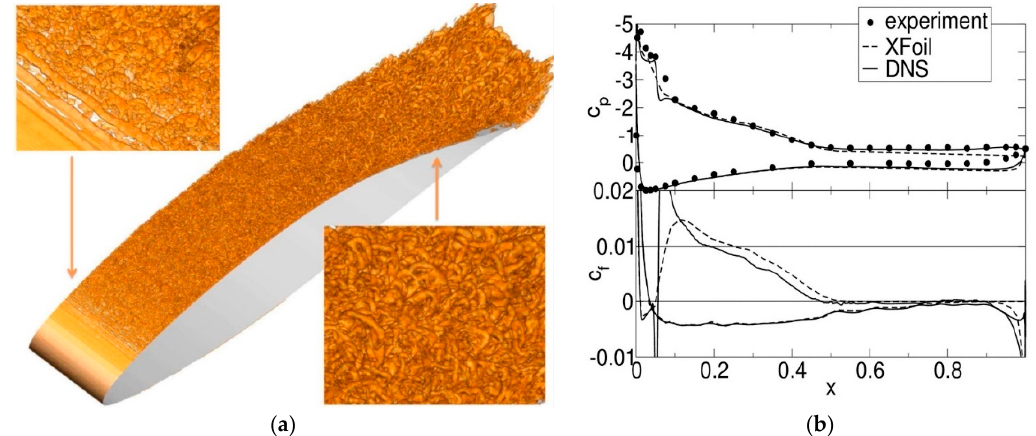
Figure 22. Re = 300,000 and α = 15 degrees. ( a ) Instantaneous Q = 100 surfaces and ( b ) wall pressure and skin-friction coefficient. (Reprinted from [33]).